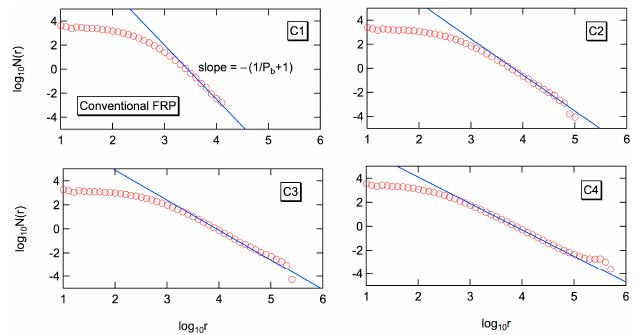
Figure 4. Double logarithmic plot of the number fraction distribution of the polymers formed through the conventional free-radical emulsion polymerization, for the conditions C1–C4.